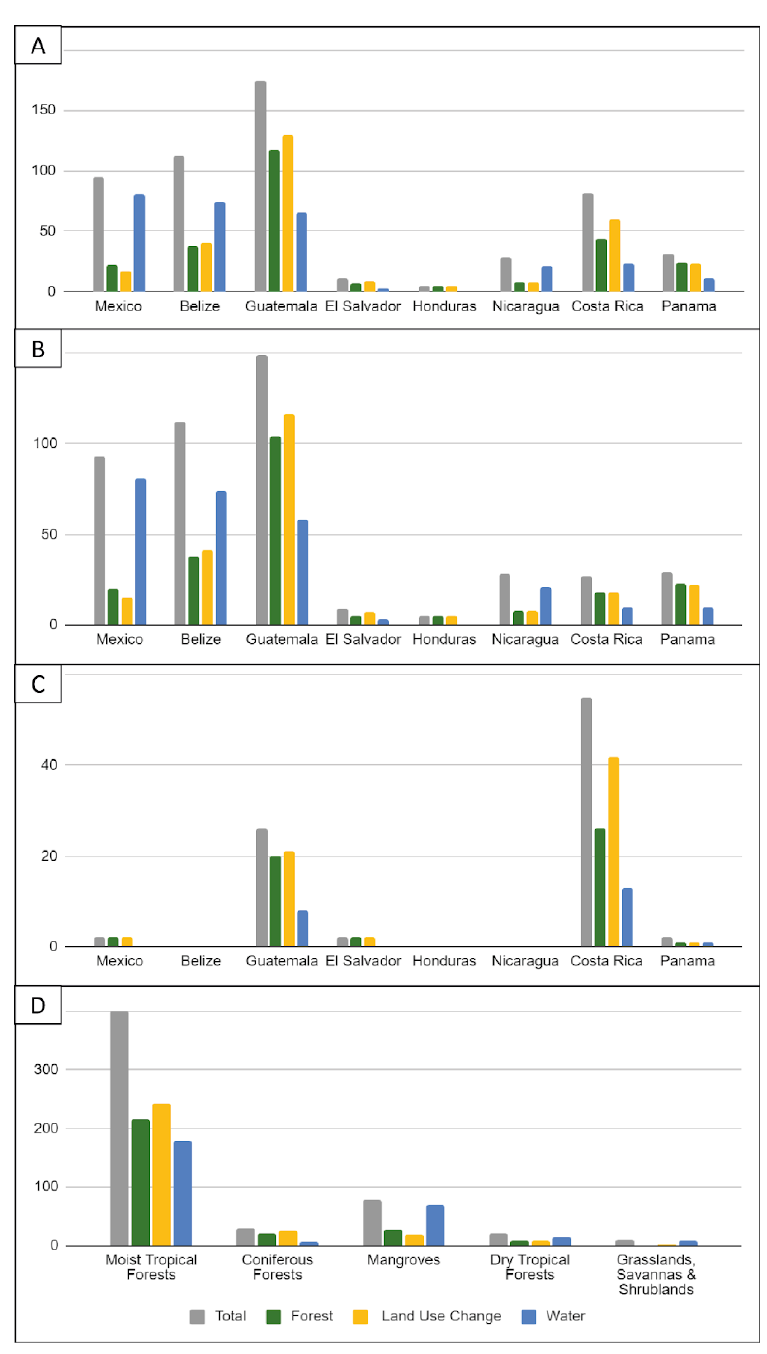
Figure 7. Location of studies presented in the evidence base: (i) Total; (ii) Forest; (iii) Land Use Change; (iv) Water. ( A ) Number of studies in each country; ( B ) Number of studies in each country >1000 m.a.s.l.; ( C ) Number of studies in each country >1000 m.a.s.l.; ( D ) Number of studies in each forest type. 0, 0%), Nicaragua ( n = 0, 0%), Belize ( n = 0, 0%), Mexico ( n = 2, 0.4%), Panamá ( n = 2, 0.4%), El Salvador ( n = 2, 0.4%), and Guatemala ( n = 26, 4.8%); and lowlands of Honduras ( n = 5, 0.9%), El Salvador ( n = 9, 1.7%), Costa Rica ( n = 27, 5%), Nicaragua ( n = 28, 5.2%), and